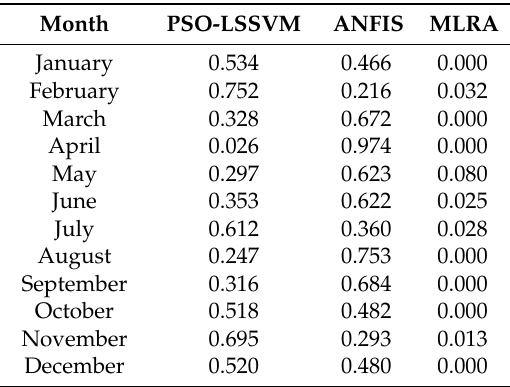
Table 8. The monthly weights of three individual operating rules for the BMA